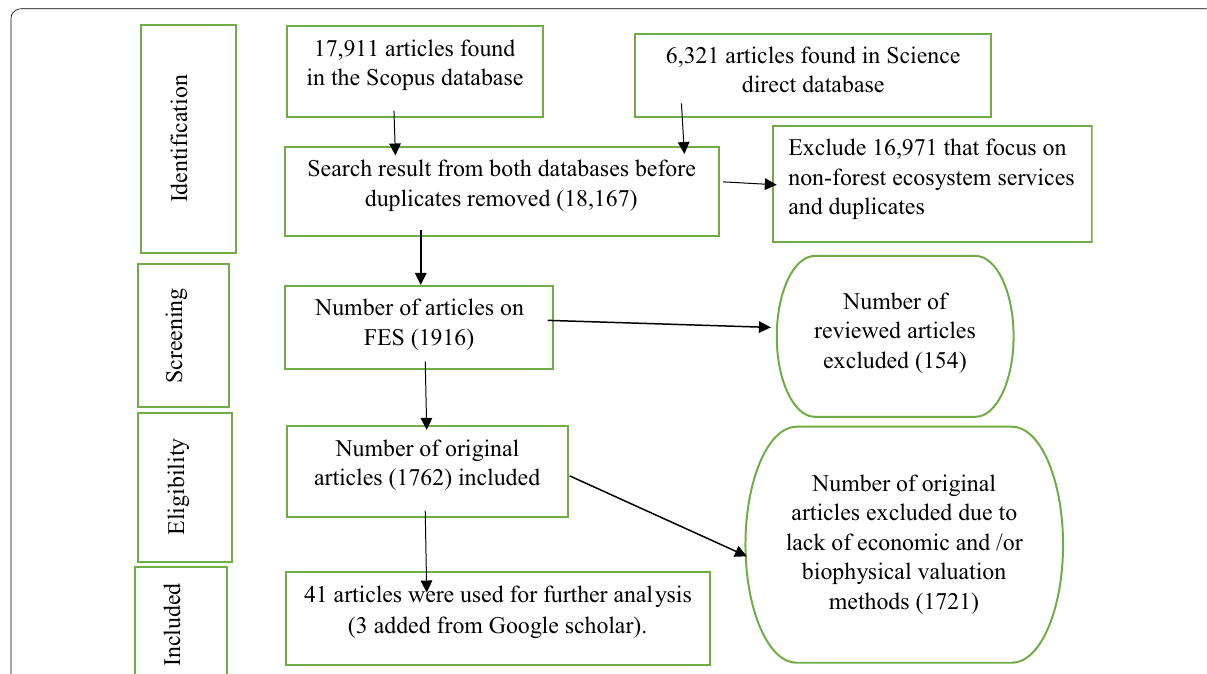
Fig. 1 The flow diagram for database search of publications for systematic reviews. This figure demonstrates the process of selecting the final articles related on the topic for further analysis. The number of articles was large in number, when the search was any ecosystem service research work. However, when the criteria is going to be more specific to FES and its methods used to quantify/qualify, mapping and value the ecosystem services, thus the size of the articles was reduced Source: Modified from Moher et al.